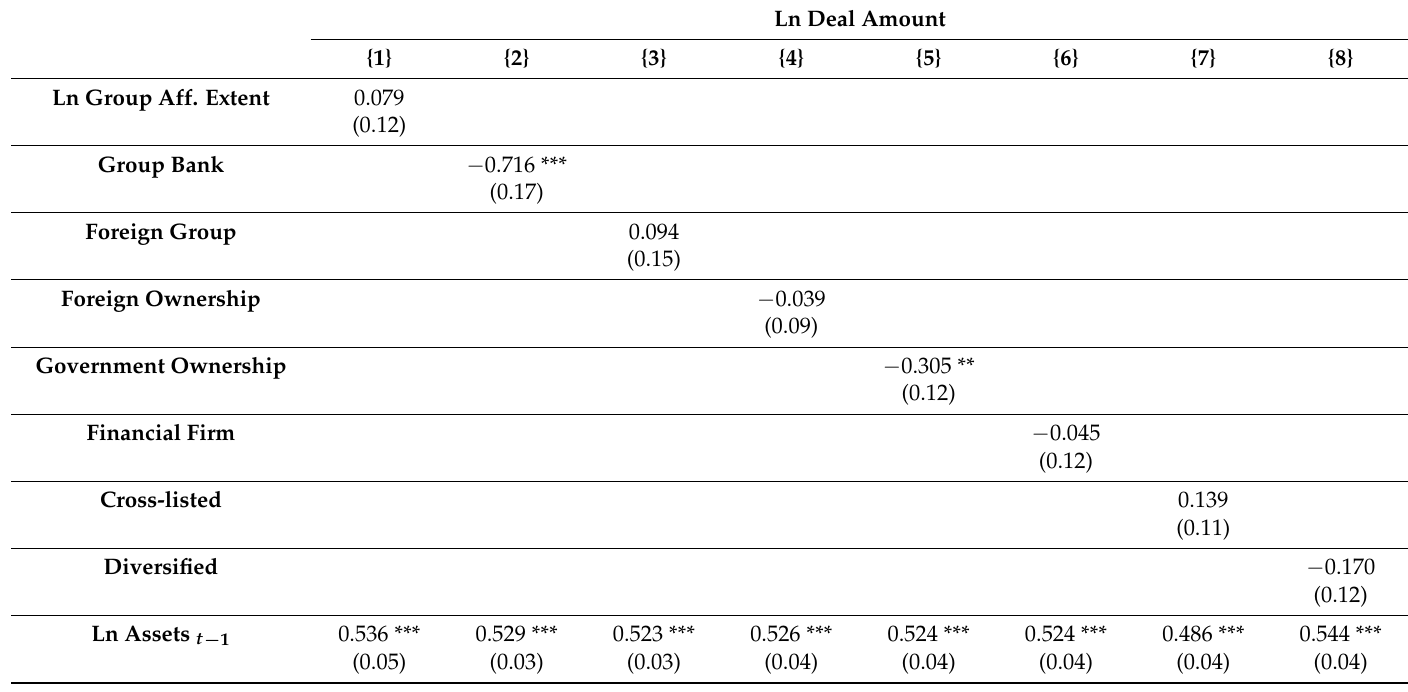
Table 6. OLS regressions of Deal Amount on Group Affiliation Extent, Group Bank, Foreign Group, Foreign Ownership, Government Ownership, Financial Firm, Cross-listed, Diversified, and Borrower and Loan Characteristics. Table 6 presents the pooled ordinary least squares (OLS) regression results of ln (Deal Amount) on Group Affiliation Extent, Group Bank, Foreign Group, Foreign Ownership, Government Ownership, Financial Firm, Cross-listed, Diversified, and Borrower and Loan Characteristics. Group Affiliation Extent is calculated based on the percentage of group ownership in borrower firms (0% indicates that there is no group association, and 100% means that the associated group owns all the firm’s shares). Binary variables indicate whether a Group Bank, Foreign Ownership, Government Ownership, or Foreign Group Affiliation exist, and whether the borrower is Focused or Diversified, whether it is a Financial Firm, and whether it is Cross-listed. Control variables include firm and loan characteristics, and loan type, year, and industry dummies. Robust standard errors are reported in parentheses. Each model is clustered at the group level to control for possible group fixed effects. *, **, and *** represent significance levels of 10%, 5%, and 1%